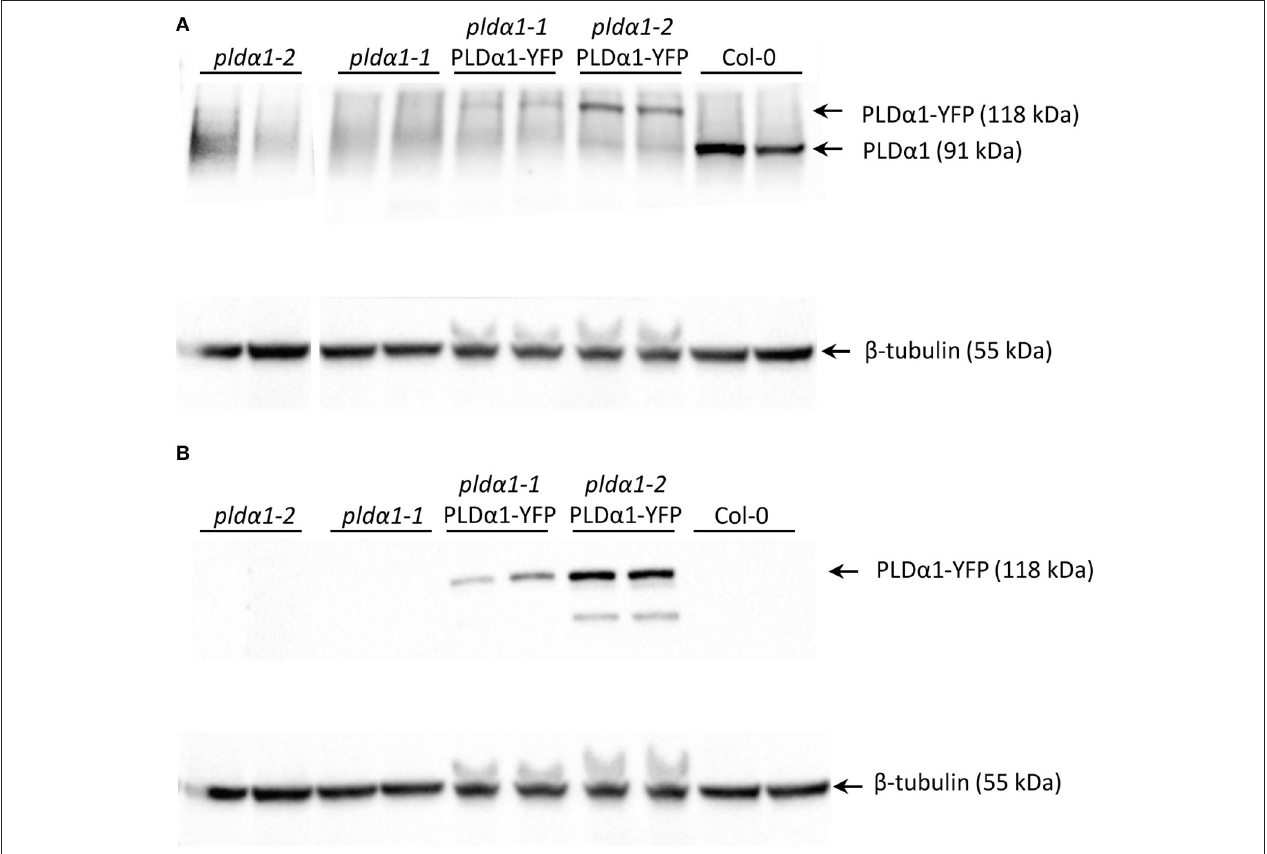
FIGURE 1 | Detection of PLD α 1 in roots of pld α 1 mutants and in rescued pld α 1 mutants stably transformed with proPLD α 1::PLD α 1:YFP construct. (A) Immunoblots of pld α 1 mutants and rescued pld α 1 mutants probed with anti-PLD α 1/2 antibody. (B) Immunoblots of pld α 1 mutants and rescued pld α 1 mutants probed with anti GFP antibody. PVDF membranes (BioRad) were probed with anti-beta tubulin as a loading